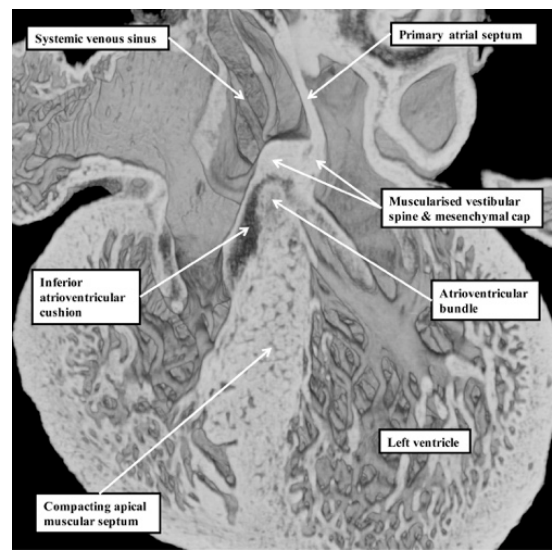
Figure 7. This image is a “four chamber” section through a dataset obtained from a developing mouse embryo at embryonic day 14.5. The location of the atrioventricular bundle, sandwiched between the crest of the muscular ventricular septum and the insulating tissues derived from the atrioventricular cushions, shows that there is no ventricular “septum of the atrioventricular canal” [8]. As can be seen, the structure responsible for dividing the initially common atrioventricular canal—the vestibular spine [9,10]—forms the antero-inferior buttress of the atrial septum.